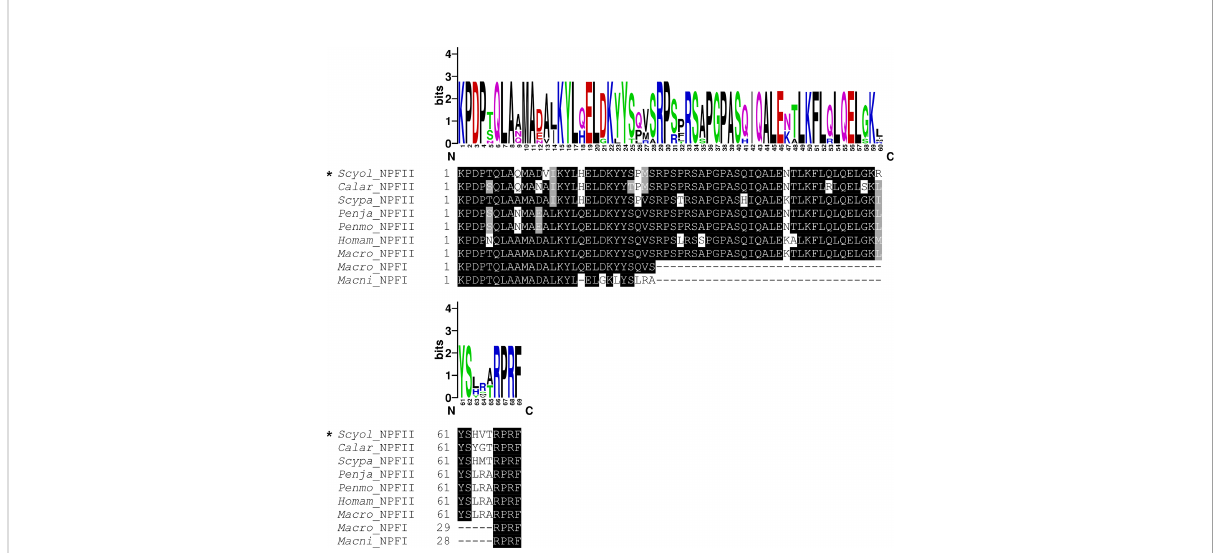
FIGURE 7 Comparative analysis of the active peptide of NPF II protein sequence with other species. The multiple alignments of NPF II of S. olivacea proteins with NPF proteins in other species from crustaceans. Black shading in the multiple alignments indicates conserved amino acids while gray shading indicates similar amino acids. The asterisks indicate S. olivacea NPF II found in this study. The sequence logo above the alignment shows the conservation of amino acid residues.